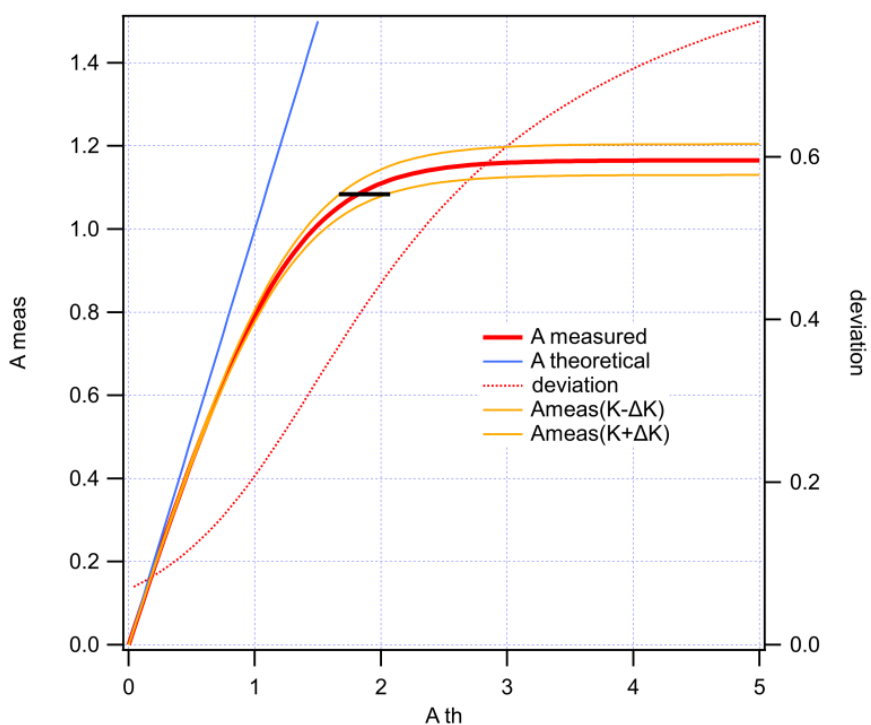
Figure A1. Calculated measured absorbance (red line) in the presence of a background equal to 7.3% of the incident intensity as a function of the ideal absorbance (i.e., K = 0, blue line). The underestimation increases for higher values of the absorbance, i.e., for smaller values of the transmitted intensity. The corresponding deviation (difference theoretical absorbance—measured absorbance) is reported as dot orange line. The variation of the measured absorbance using the maximum and minimum value of K within the error bar is also reported in yellow.